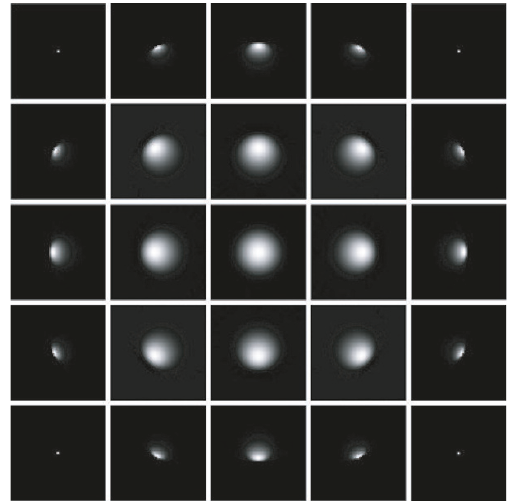
Figure 3: The 5 × 5 array of the invariant PSFs corresponding to individual